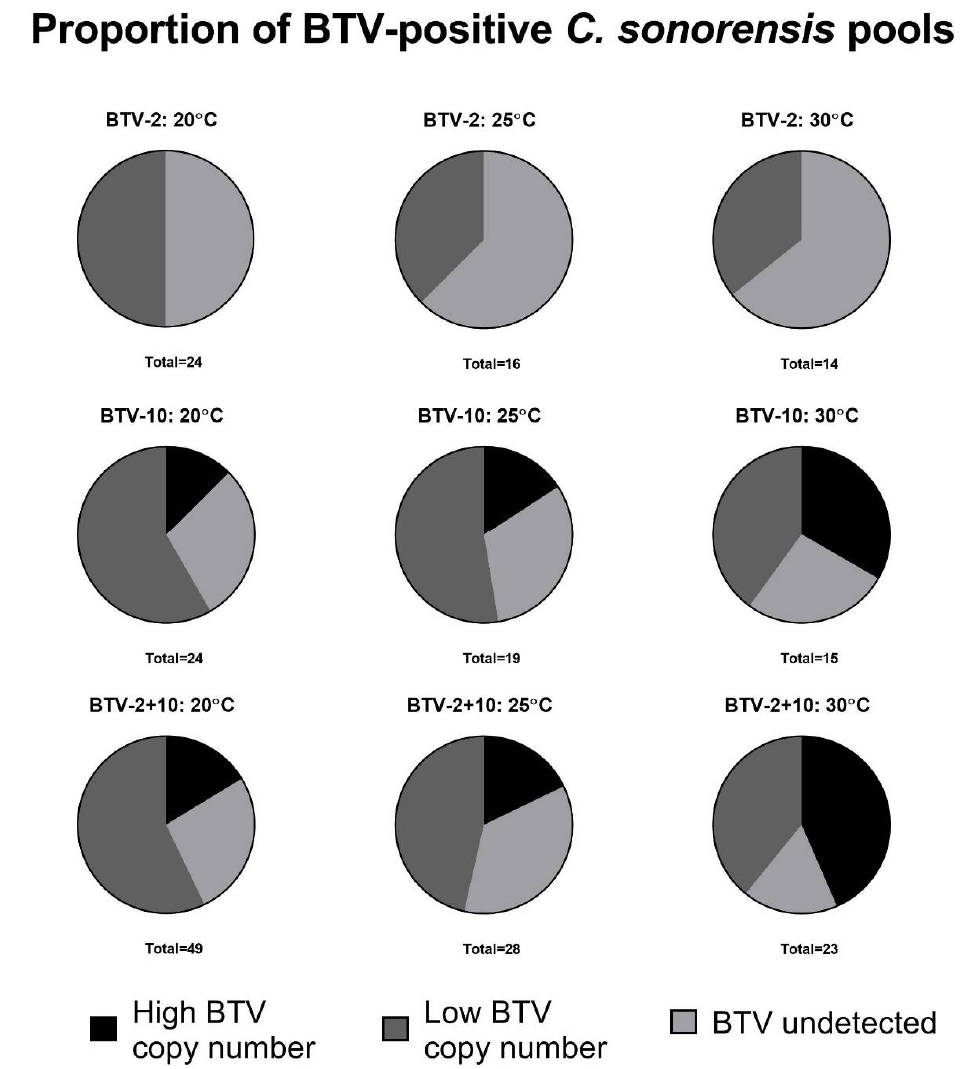
Figure 4. Proportion of BTV-positive C. sonorensis pools at each temperature. Pie charts represent the proportion of BTV-positive midge pools at each temperature across virus exposure conditions (BTV-2 only; BTV-10 only; BTV-2+10) when midges imbibed a blood meal containing a total MOI of ~1 × 10 5 TCID50/mL. The total number of pools screened for BTV via qRT-PCR is noted beneath each pie chart. “High BTV copy number” indicates pools of midges where BTV −ΔCt values became greater than the day 0 –ΔCt value (−7.5), consistent with productive virogenesis. “Low BTV copy number” indi- cates pools of midges where BTV was detectable via qRT-PCR, but −ΔCt values were less than the day 0 –ΔCt value (−7.5). Productive virogenesis was not considered to have occurred in these pools. A greater proportion of midge pools demon- strate productive BTV virogenesis at 30 °C compared to lower temperatures. Insects infected with BTV-2 alone failed to demonstrate productive virogenesis regardless of incubation temperature. Table 2. ΔCt values for pools of midges following exposure to higher titers of BTV-2. ΔCt is calculated as the difference between mean BTV Ct values and cox 1 Ct values for each sample. Day 0 values represent the ΔCt value in midges (n = 5) collected immediately following ingestion of BTV-2 spiked blood meal. Pools of n = 5 midges were subsequently collected and screened on days 7, 11, and 14. “UND” indicates that the BTV Ct value was beyond the limit of detection in a pool of midges. Virus isolation was performed on one pool of midges collected at day 14 (indicated by *) for both the BTV-2 LO and HI groups. ˄ Indicates that the virus was successfully isolated from midges (day 14, BTV-2 LO). For these experiments, BTV virogenesis was considered to occur when cox 1-normalized BTV Ct values approached the baseline day 0 BTV ΔCt level.